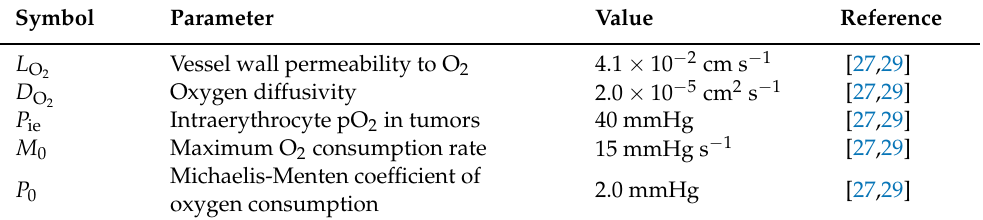
Table 2. Model parameter values used in tissue oxygenation simulations